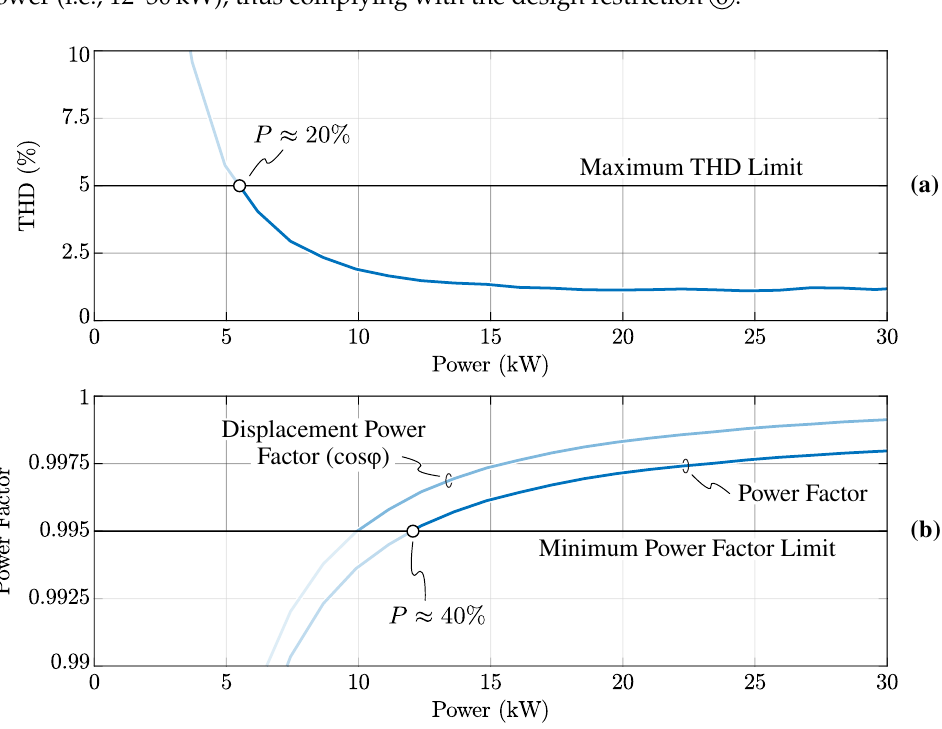
Figure 18. Experimentally measured grid-side current total harmonic distortion (THD) ( a ) and power factor ( b ) as functions of the transferred power. The maximum THD limit and the minimum power factor requirement are